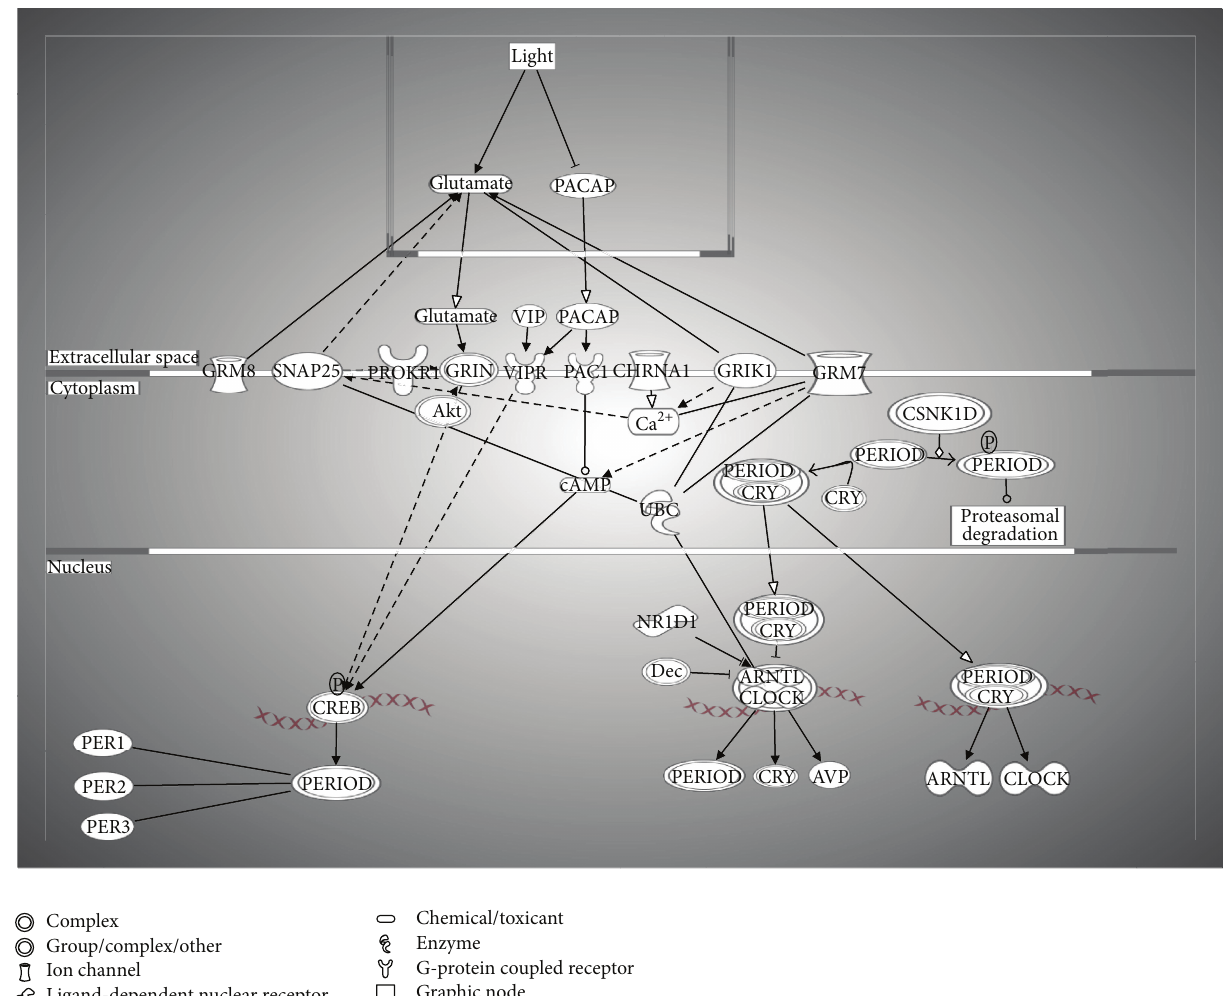
Figure 3: Circadian Rhythm Signaling pathway. The Entrez gene names and their symbols represented in this network: Akt; Arntl-Clock; arginine vasopressin (AVP); Aryl hydrocarbon receptor nuclear translocator-like (BMAL1); cholinergic receptor, nicotinic, alpha 1 (muscle) (CHRNA1); CK1 𝜀 /CK1 𝛿 ; clock circadian regulator (CLOCK); CREB; CRY; Cry-Period; glutamate receptor, ionotropic, kainate 1 (GRIK1); GRIN; glutamate receptor, metabotropic 7 (GRM7); glutamate receptor, metabotropic 8 (GRM8); adenylate cyclase activating polypeptide 1 (pituitary) receptor type I (PAC1); adenylate cyclase activating polypeptide 1 (pituitary) (PACAP); period circadian clock 1 (PER1); period circadian clock 2 (PER2); period circadian clock 3 (PER3); period circadian clock, group (PERIOD); prokineticin receptor 1